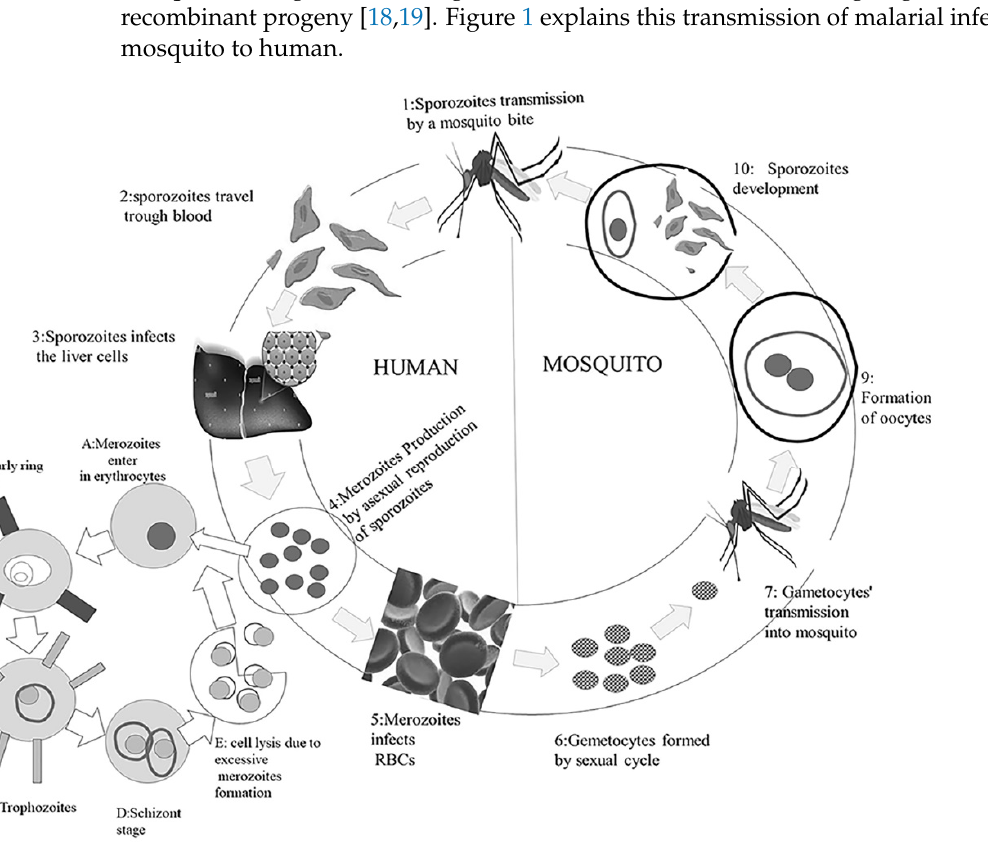
Figure 1. Transmission of malarial infection from mosquito to Figure 1 . Transmission of malarial infection from mosquito to human.